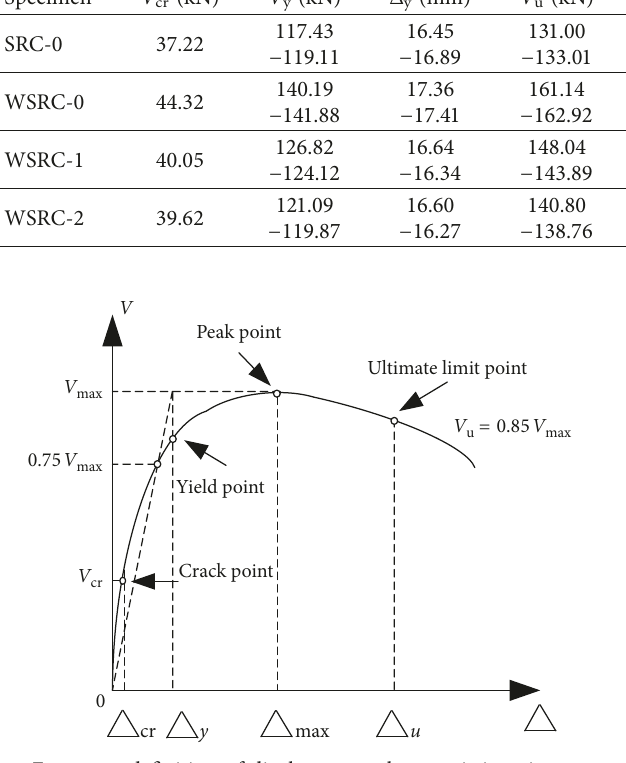
Figure 7: definition of displacement characteristic